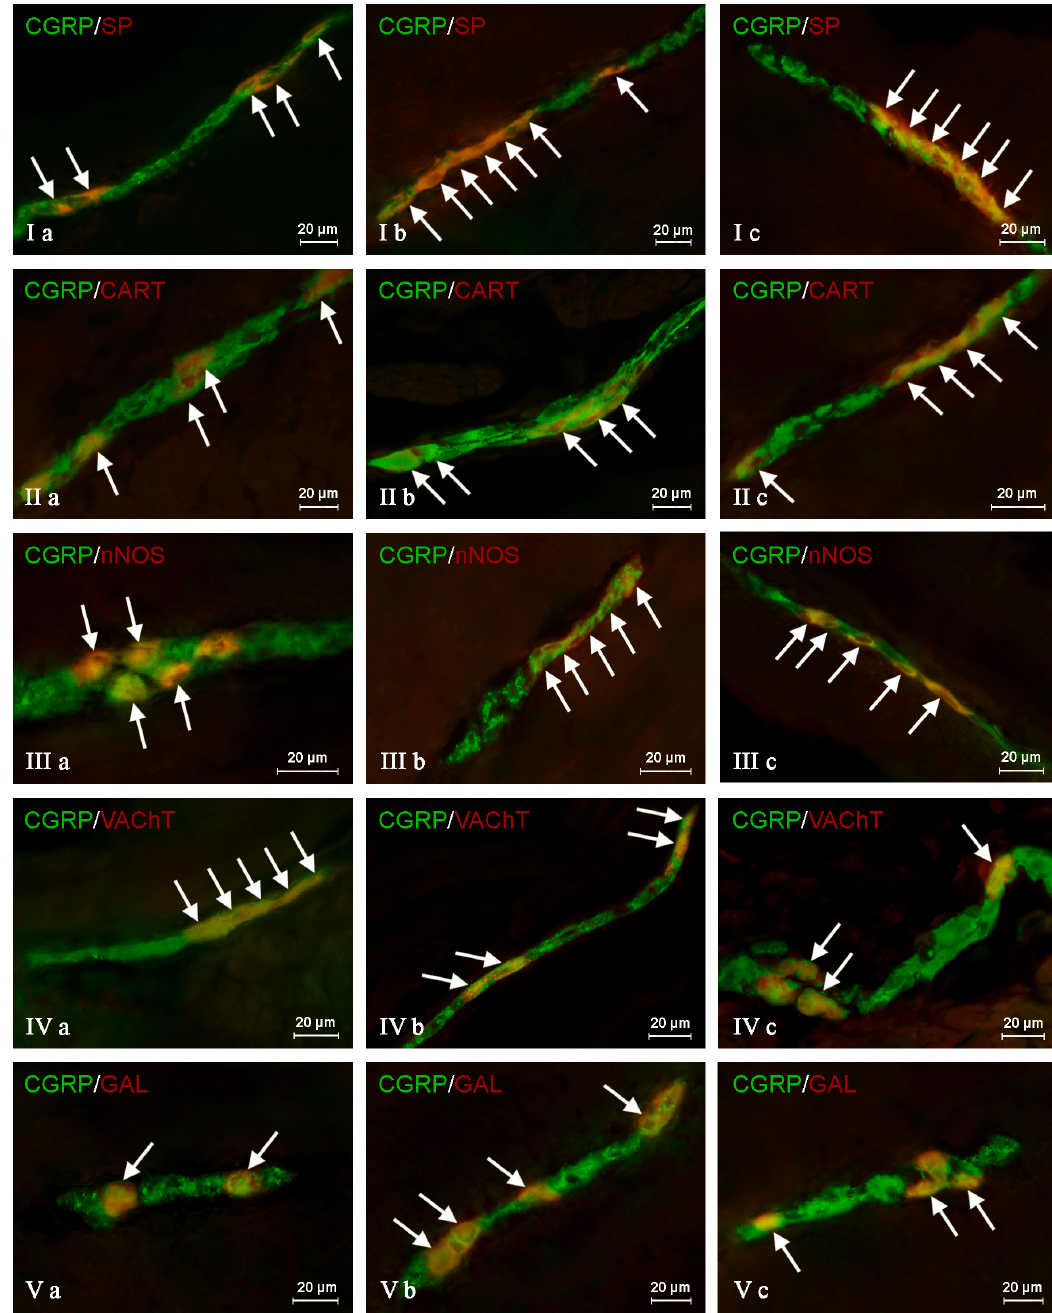
Figure 3. Representative images of the co-localization of the calcitonin gene-related peptide (CGRP) with other neuronally-active substances in the neurons of the myenteric plexus of the porcine descending colon under physiological conditions ( a ), after axotomy ( b ) and during inflammation ( c ). (I) Co-localization of CGRP with substance P (SP); (II) co-localization of CGRP with cocaine- and amphetamine-regulated transcript (CART) peptide; (III) co-localization of CGRP with the neuronal isoform of nitric oxide synthase (nNOS); (IV) co-localization of CGRP with vesicular acetylcholine transporter (VAChT); (V) co-localization of CGRP with galanin (GAL). Images are composites of merged images taken separately from green (CGRP) and red (other substances studied) fluorescent channels. Nervous structures where CGRP co-localizes with other substances are indicated by arrows.